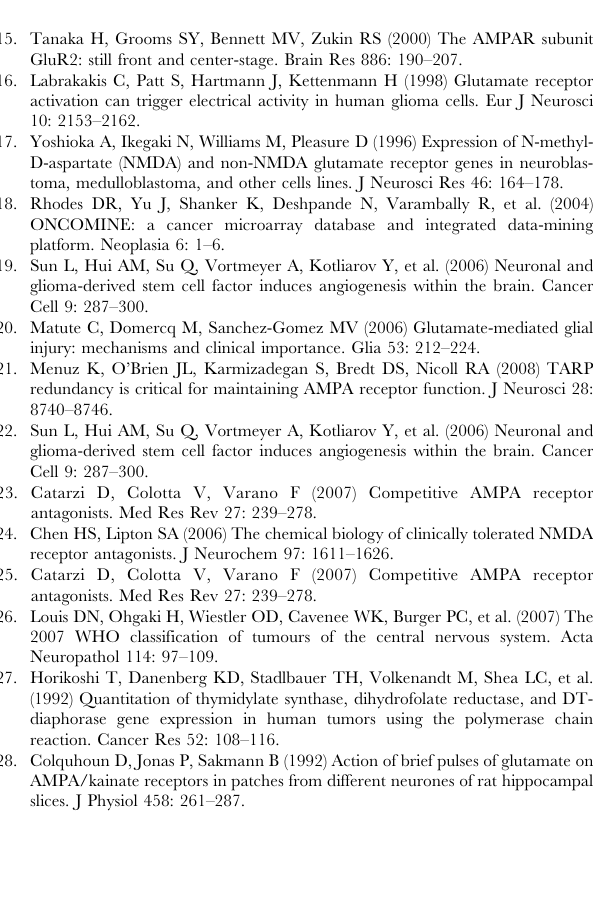
Figure S3 In silico analysis of transmembrane AMPAR regulatory proteins (TARPs) expression levels in GBM tumors. Expression of transmembrane AMPAR regulatory protein gamma 2 and 3 (TARP- c 2 and TARP- c 3) in a dataset of 77 glioblastomas (grey dashed), compared to non-neoplastic, normal brain from epilepsy surgery (white) (p , 0.0001, t-test value 8.772 and 12.903 respectively).